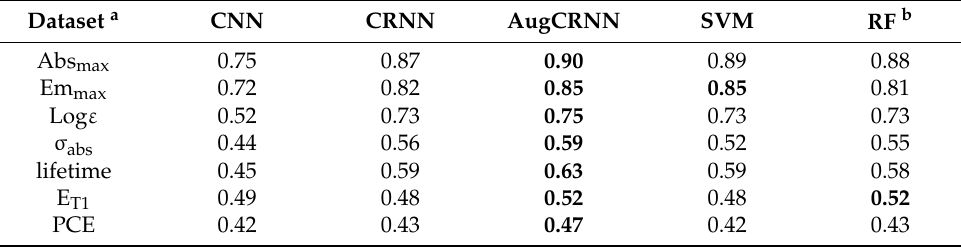
Table 4. Coefficient of determination (r 2 ) for regression datasets of material properties.